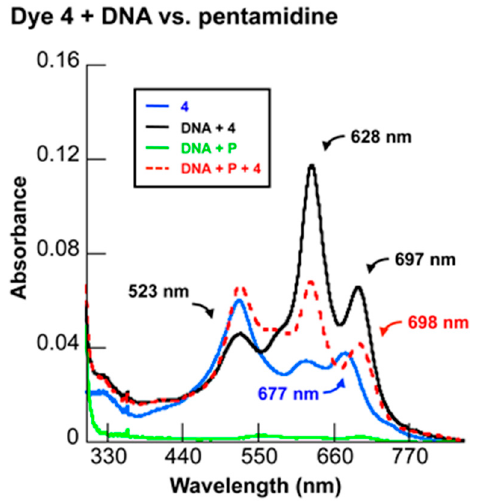
Figure 8. UV–visible absorption spectra recorded for: dye 4 without CT DNA (blue lines); dye 4 with CT DNA (black lines); pentamidine (P) with CT DNA (green lines); and dye 4 with DNA pre-equilibrated for one min with pentamidine (red lines). All samples contained 10 mM sodium phosphate buffer pH 7.0 and one or more of the following: 10 µM of dye 4 , 150 µM bp of CT DNA, and 10 µM of pentamidine.